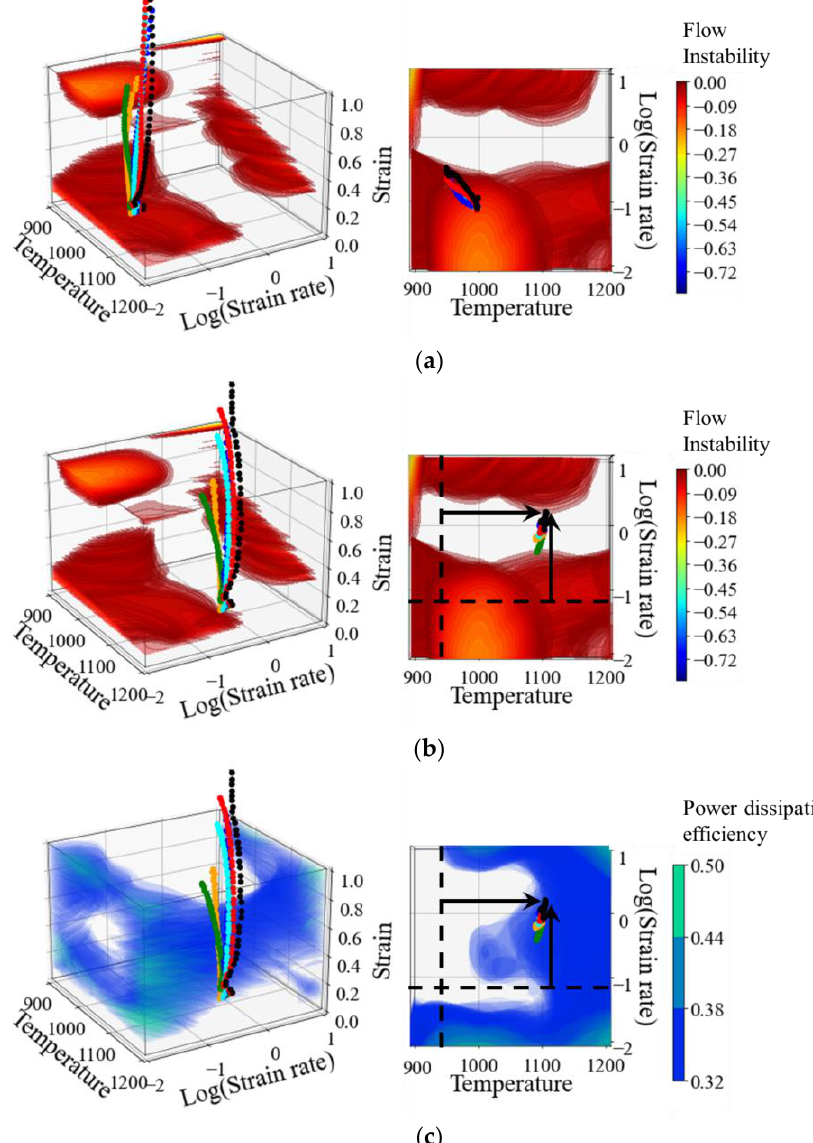
Figure 14. Control of process temperature and speed using a 3D processing map in hot forging. ( a ) The initial process, ( b ) modified process on the 3D flow instability map, ( c ) modified process on the 3D power dissipation efficiency map.